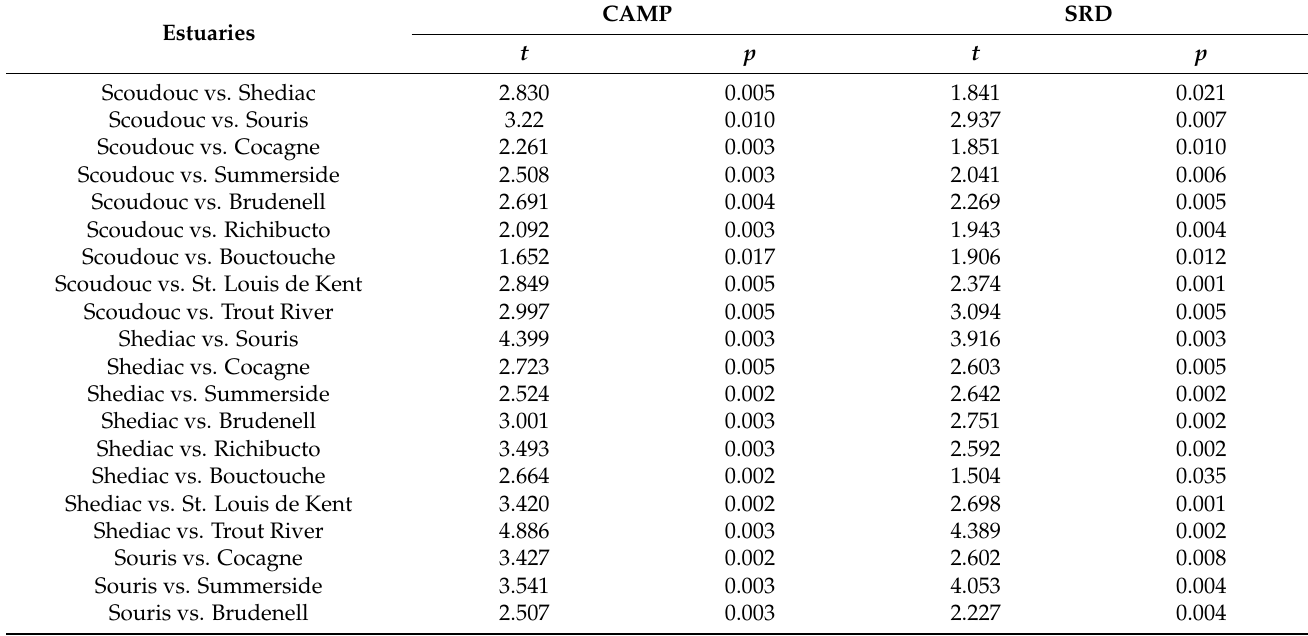
Table 4. Comparison of permutational-MANOVA (PERMANOVA) pair-wise tests among factor Estuary within factor Sampling Design for nekton data collected from the Community Aquatic Monitoring Program (CAMP) and Stratified Random Design (SRD)